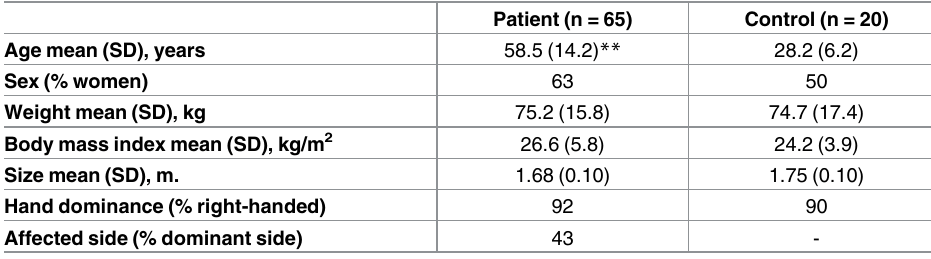
Table 1. Participants’